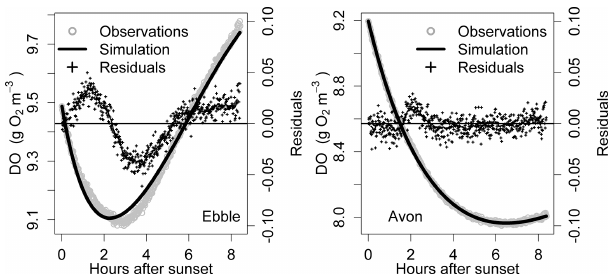
Figure 7. Nighttime simulations for 16/17 May for Ebble and Avon. For Ebble, median DOD zero (cid:49) DO is 1.7 and regression quotient is 1.6, whereas for the Avon, they are equal (3.05).